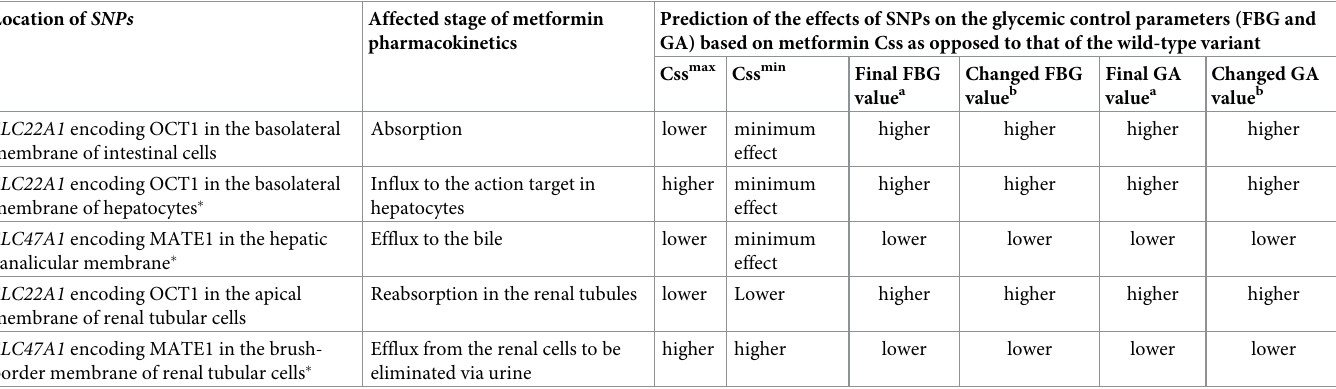
SLC22A1 encoding OCT1 in the apical membrane of renal tubular